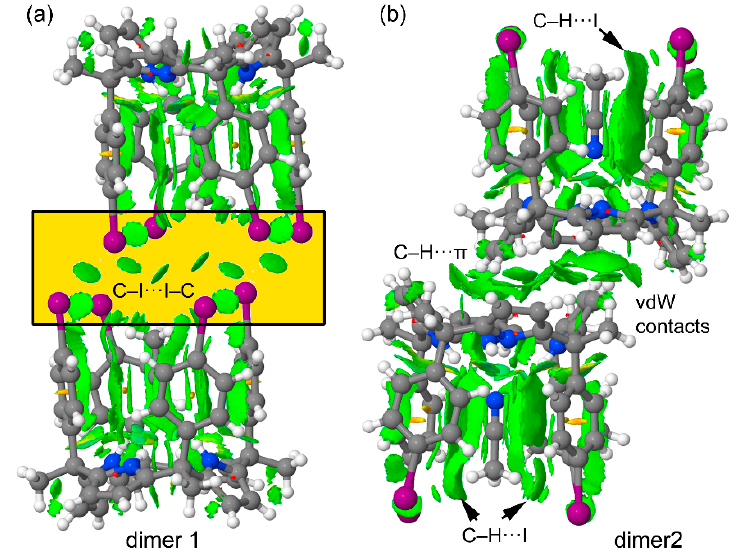
Figure 7. NCIPLOTs of dimer 1 ( a ) and dimer 2 ( b ) retrieved from the X-ray structure of polymorph B . The gradient cut-off is s = 0.35 au, and the color scale is − 0.04 < ρ < 0.04 au.